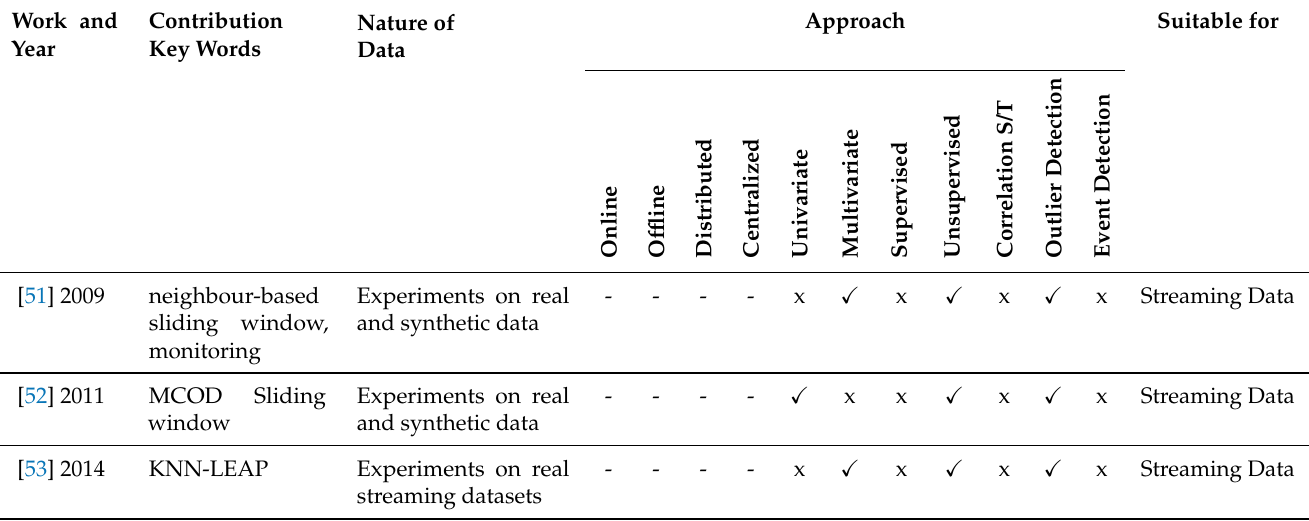
Table 4. Comparative Table of KNN Based